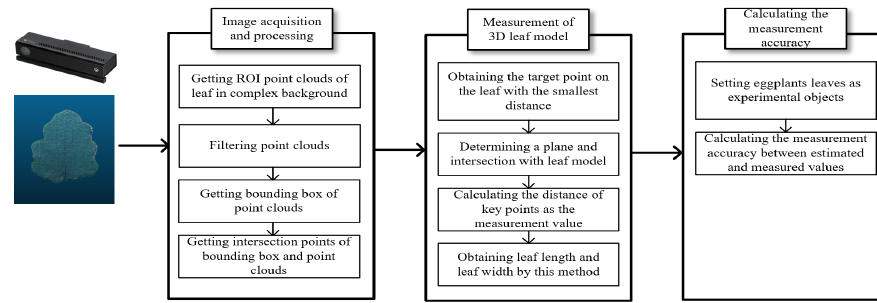
Figure 1. Operation flowchart of the